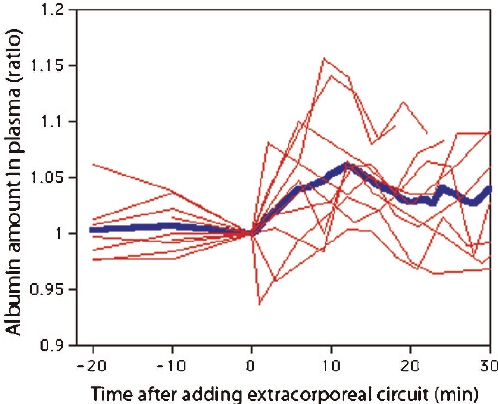
Figure 3 - Relative change of intravascular albumin mass with start of CPB (0) as baseline. Each red line represents one patient. Blue line is the mean value.